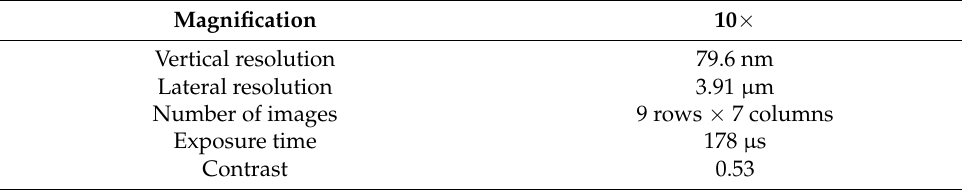
Table 1. Alicona G4 measurement device main